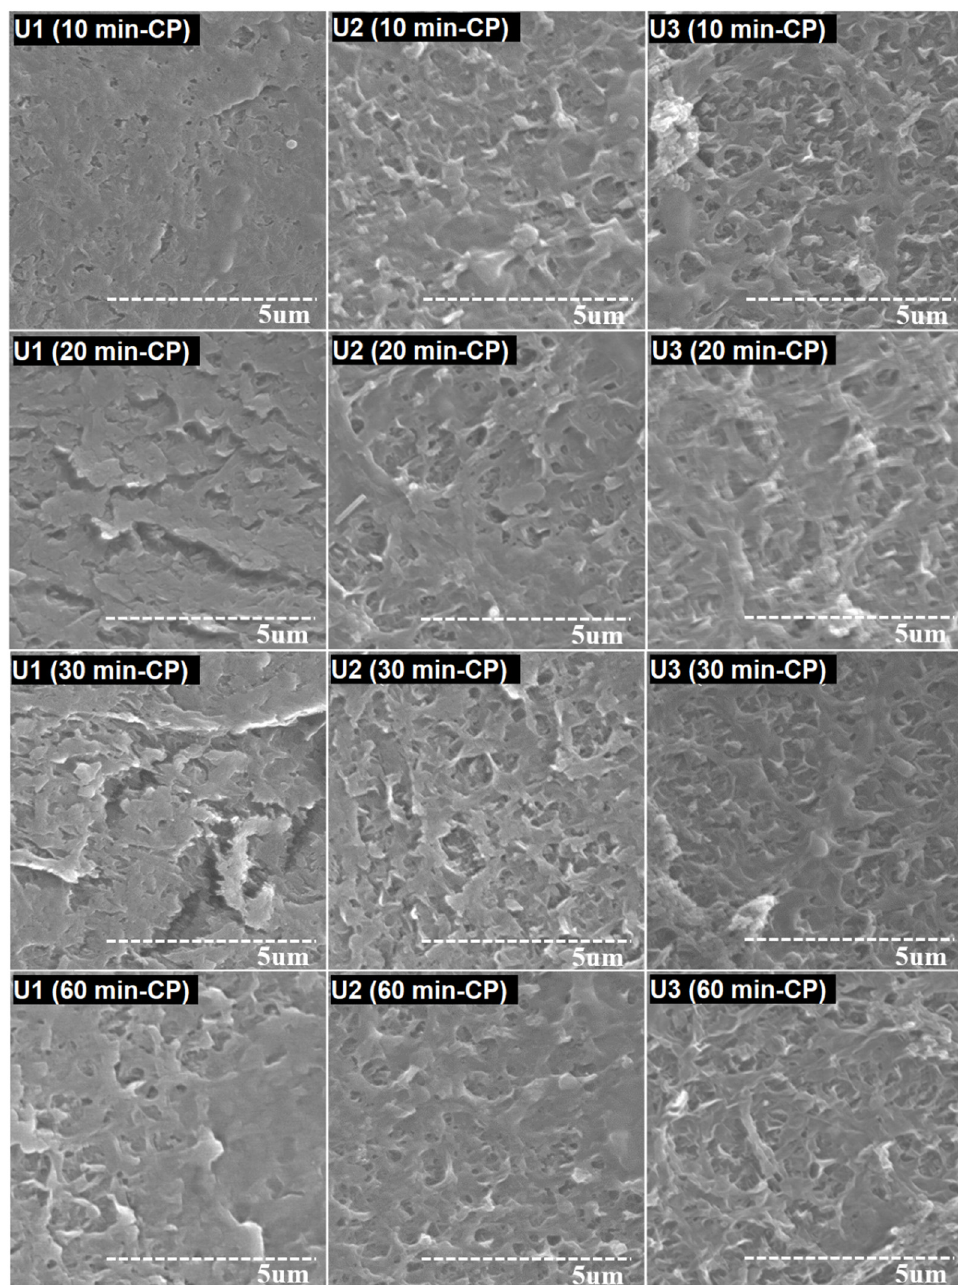
Figure 7. SEM images of RO membranes after 10, 20, 30, and 60 min of chemical